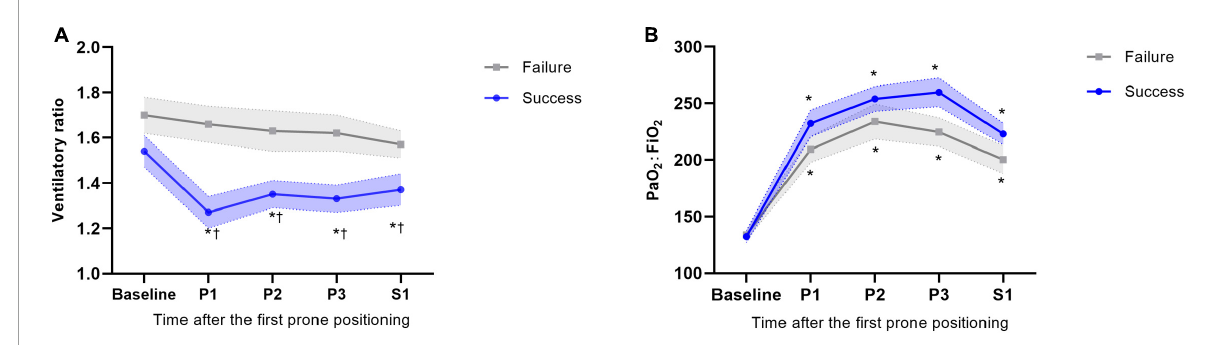
FIGURE2 Physiological response to prone positioning according to subgroups of successful weaning and weaning failure at day 28. (A) Ventilatory ratio response to prone positioning according to different subgroups. (B) PaO 2 :FiO 2 response to prone positioning according to different subgroups. The error interval between dotted line indicate the SE. * p < 0.05 of absolute values of different time points vs. baseline within group; † p < 0.05 of absolute value of success group vs. failure group at the same time point.